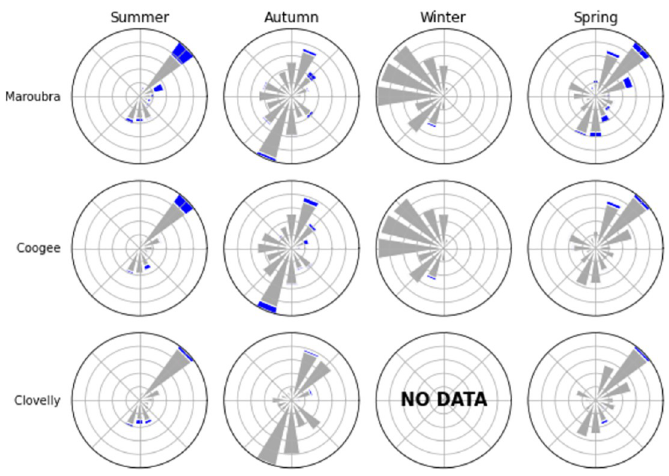
Fig 7. For each season and each site, a rose plot of wind conditions is shown. The blue part represents the portion of dates with these wind conditions and a beaching event.